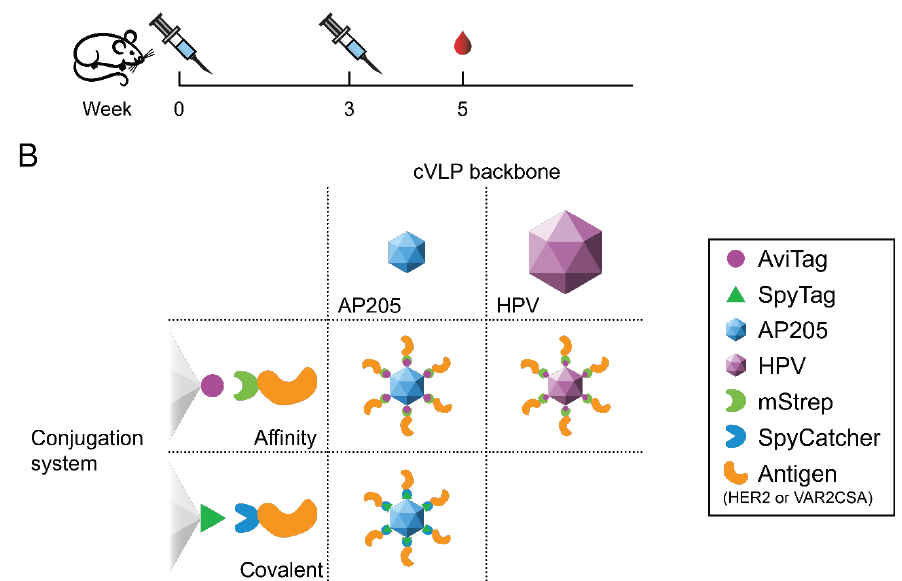
Figure 1. Study setup. ( A ) Groups of mice ( n = 6) were immunized prime-boost and serum was collected 2 weeks after the final immunization to evaluate the vaccine-induced IgG response elicited against the cVLP-displayed antigen. ( B ) Capsid virus-like particles (cVLPs) displaying either SpyTag or biotinylated AviTag were mixed with antigens genetically fused to SpyCatcher or monomeric streptavidin (mStrep), respectively. Two different model antigens (HER2 and VAR2CSA) were used. The AP205 cVLP consists of 180 subunits and has a diameter of approximately 30 nm, while the human papillomavirus (HPV) major capsid protein (L1) cVLP consists of 360 subunits and has a diameter of approximately 55 nm.